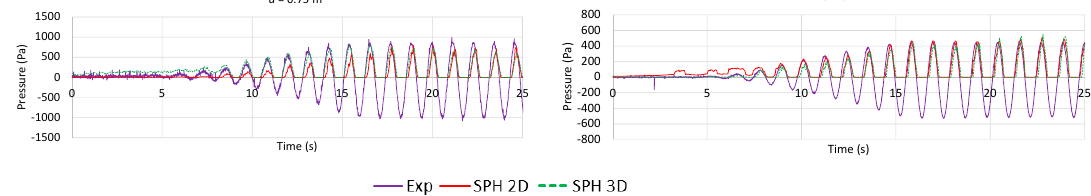
Figure 23. Comparison of wave dynamic pressure of experiment and 2-D and 3-D SPH for A = 50.5 mm and T = 1.15 s.